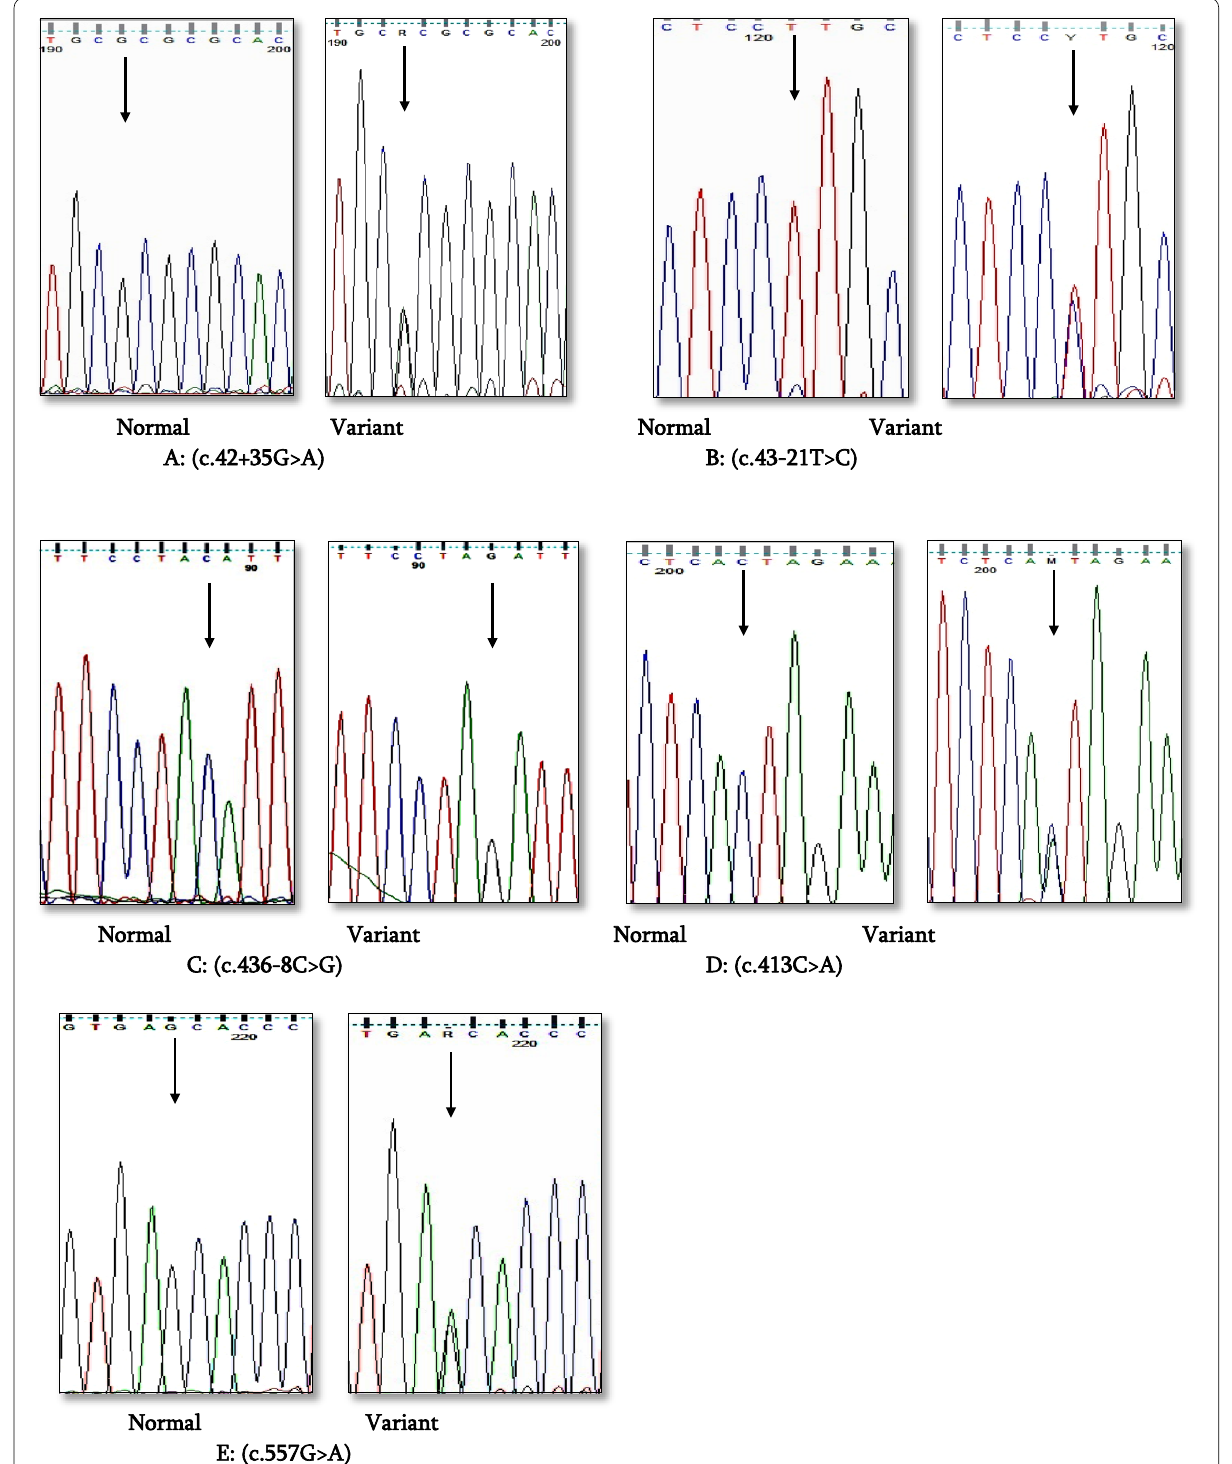
Fig. 5 Sequence chromatograms showing five reported variants in SFTPC gene. A Normal and variant of (rs8192340) c.42 normal and variant of (rs13248346) c.43‑21T>C in intron 1, C normal and variant of (rs2070687) c.436‑8C>G in intron 4, D normal and variant of (rs4715) c.413C>A in exon 4, and E normal and variant of (rs1124) c.557G>A in exon